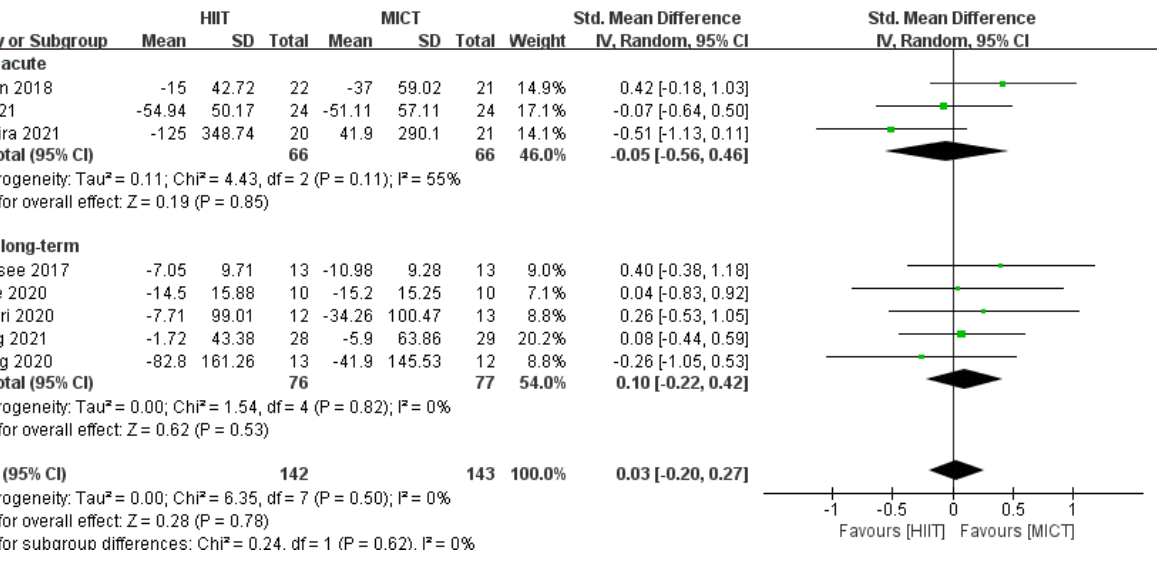
Figure 6. Subgroup analysis of HIIT and MICT in response time to the intervention period [24,25,31-36].